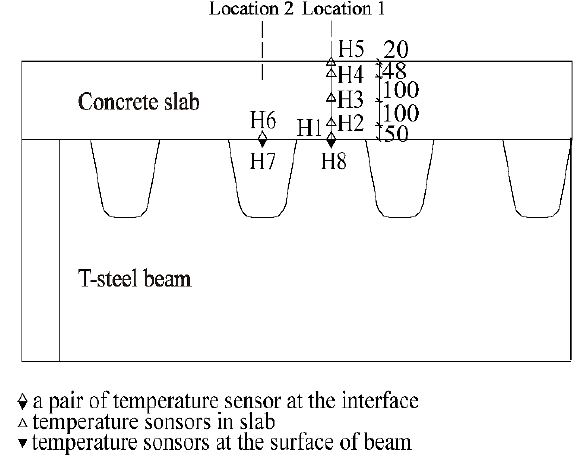
Figure 4. Distributions of temperature sensors (unit: mm).